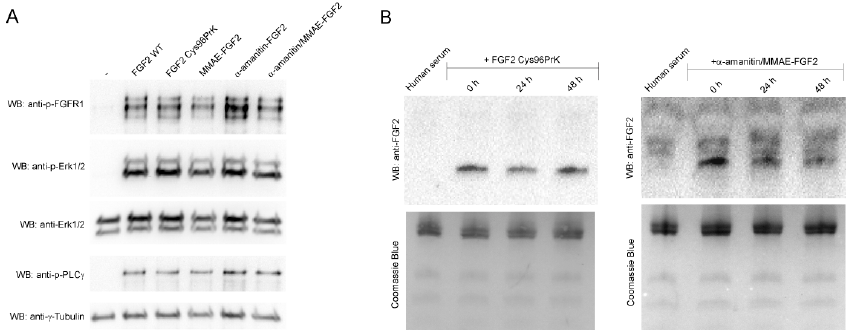
Figure 3. ( A ) Activation of signaling pathways in NIH 3T3 fibroblast cells. After binding of FGF3 and its conjugates to FGF receptors, FGFR1 phosphorylation and activation of downstream signaling pathways was analyzed by Western blotting; ( B ) Stability of FGF2 conjugates in the human serum. Either unmodified FGF2 or double conjugate were incubated for 24 or 48 h in full human serum at 37 °C and the amount of intact protein/conjugate was estimated by anti-FGF2 Western blotting (WB).